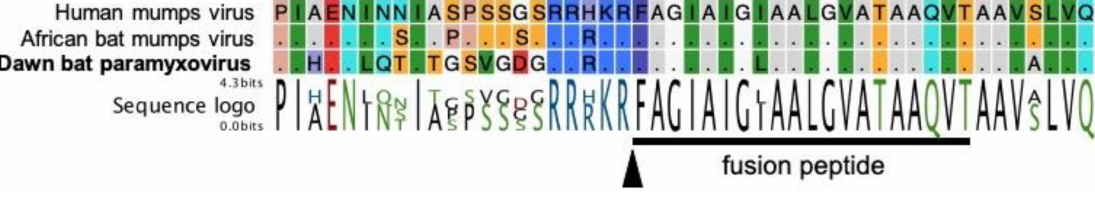
Figure 3. The conservation of a polybasic furin cleavage site among MuV (NC_002200), AbMuV (HQ660095), and DbPV in an alignment of amino acid sequences. Both AbMuV and MuV rely on proteolytic cleavage of the F protein for host cell binding and entry. Given the conservation of this furin cleavage site in DbPV, it is possible that this function is also required for the spread of infection and cell-to-cell fusion of the novel virus. Black arrowhead indicates cleavage